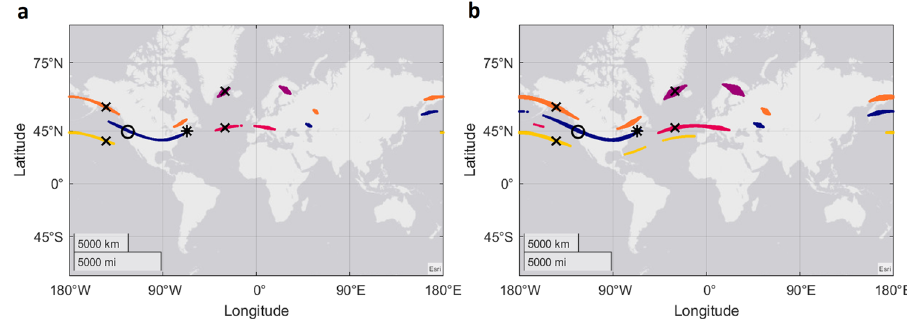
Fig. 6 All possible virtual magnetic displacement locations from ref. 20 . a Sensitivity set to ±0.5° inclination and ±200 nT total intensity. b The same virtual magnetic displacements but with sensitivity at ±0.75° inclination and ± 400 nT total intensity. Locations for each displacement as suggested in Scanlan et al., are denoted with a black cross, the possible locations for each are shown with coloured areas. The asterisk is the location of the ancestral site. Control test location under the ambient magnetic fi eld is indicated with a black